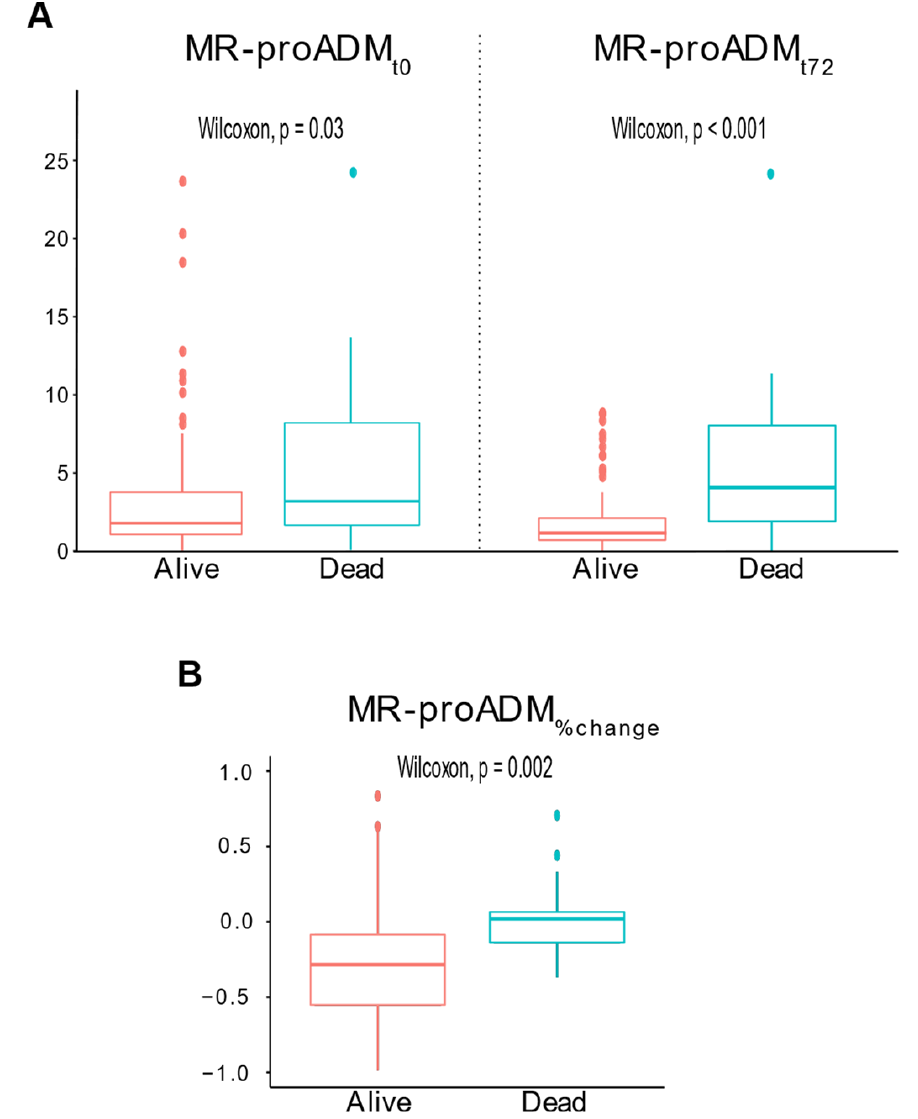
Figure 1. Boxplots of MR-proADM t0 and MR-proADM t72 for survivors and non-survivors (panel ( A )); boxplot of MR-proADM %change for survivors and non-survivors (panel ( B )).